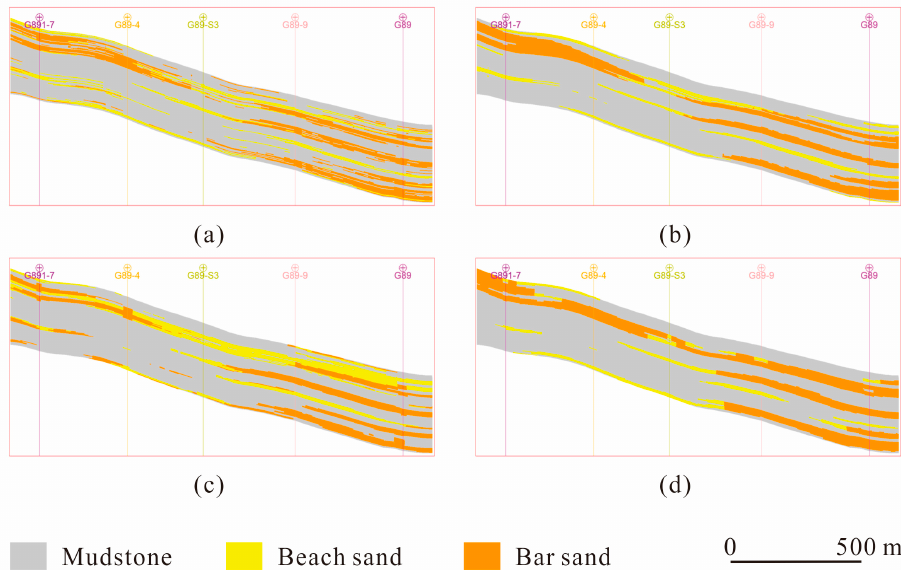
Figure 17. North-south sectional view of beach-bar model. The models are obtained by ( a ) sequential indication simulation; ( b ) object-based simulation; ( c ) multipoint geostatistical simulation; ( d ) the proposed new approach.